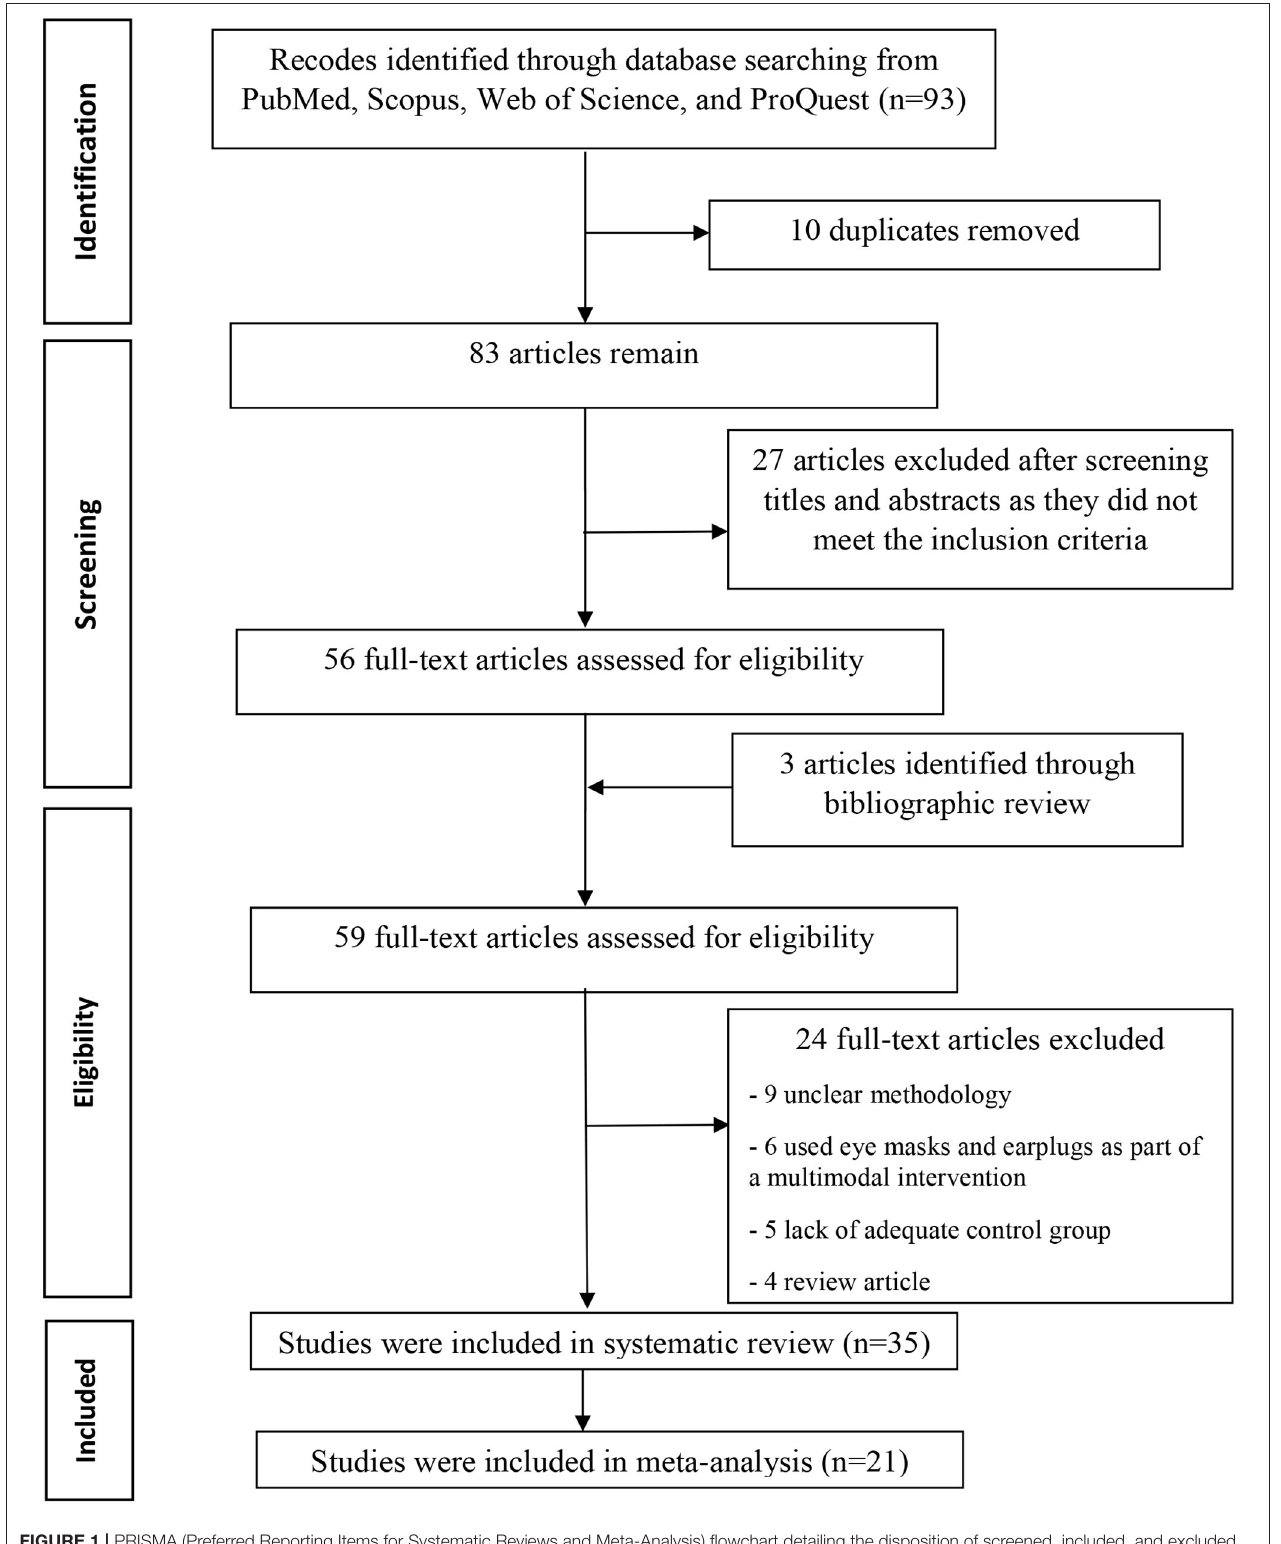
FIGURE 1 | PRISMA (Preferred Reporting Items for Systematic Reviews and Meta-Analysis) flowchart detailing the disposition of screened, included, and excluded records.